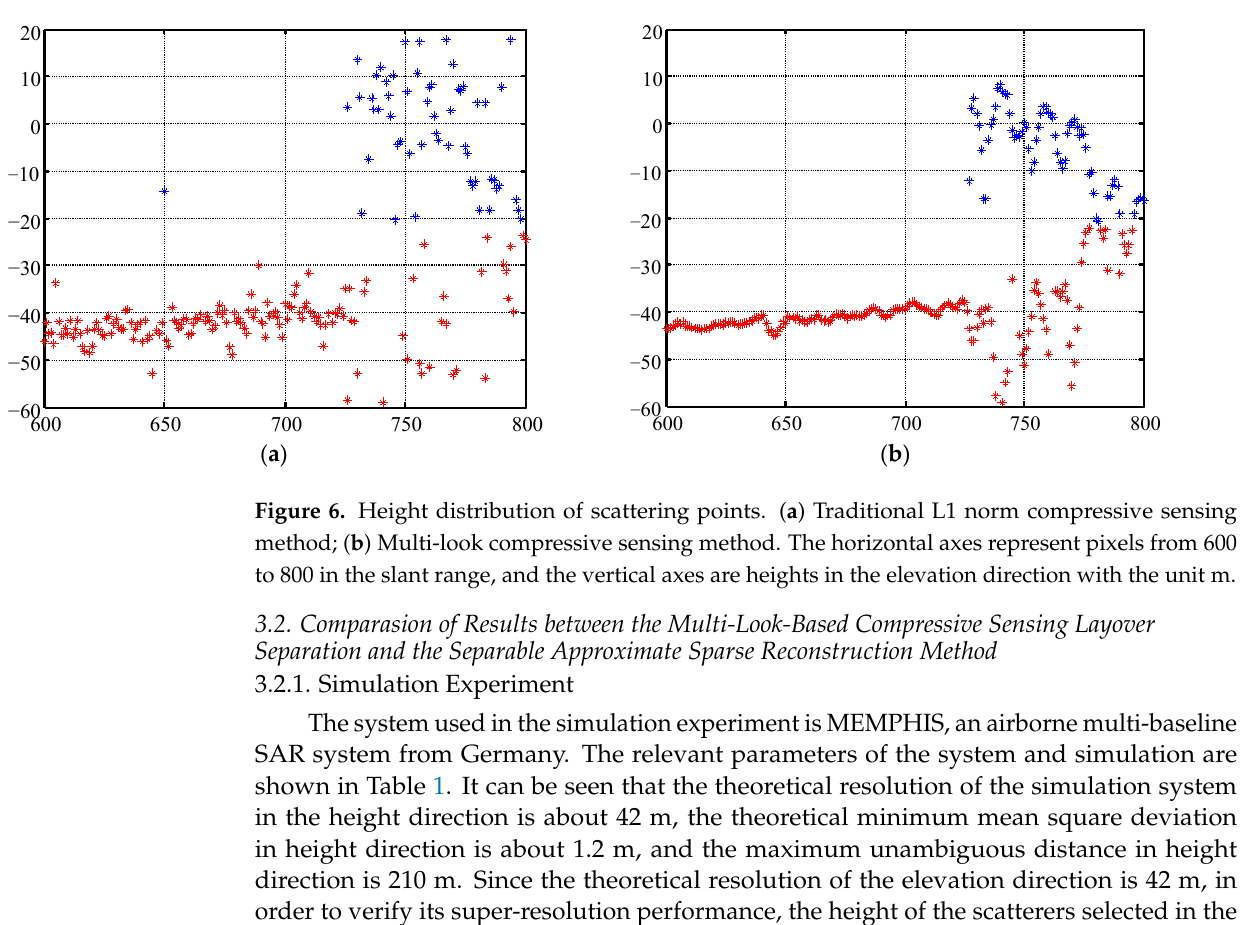
Figure 5. Normalized amplitude diagram. ( a ) Traditional L1 norm compressive sensing method; ( b ) Multi-look compressive sensing method. The horizontal axes are heights in the elevation direction with the unit m, and vertical axes represent pixels from 600 to 800 in the slant range.